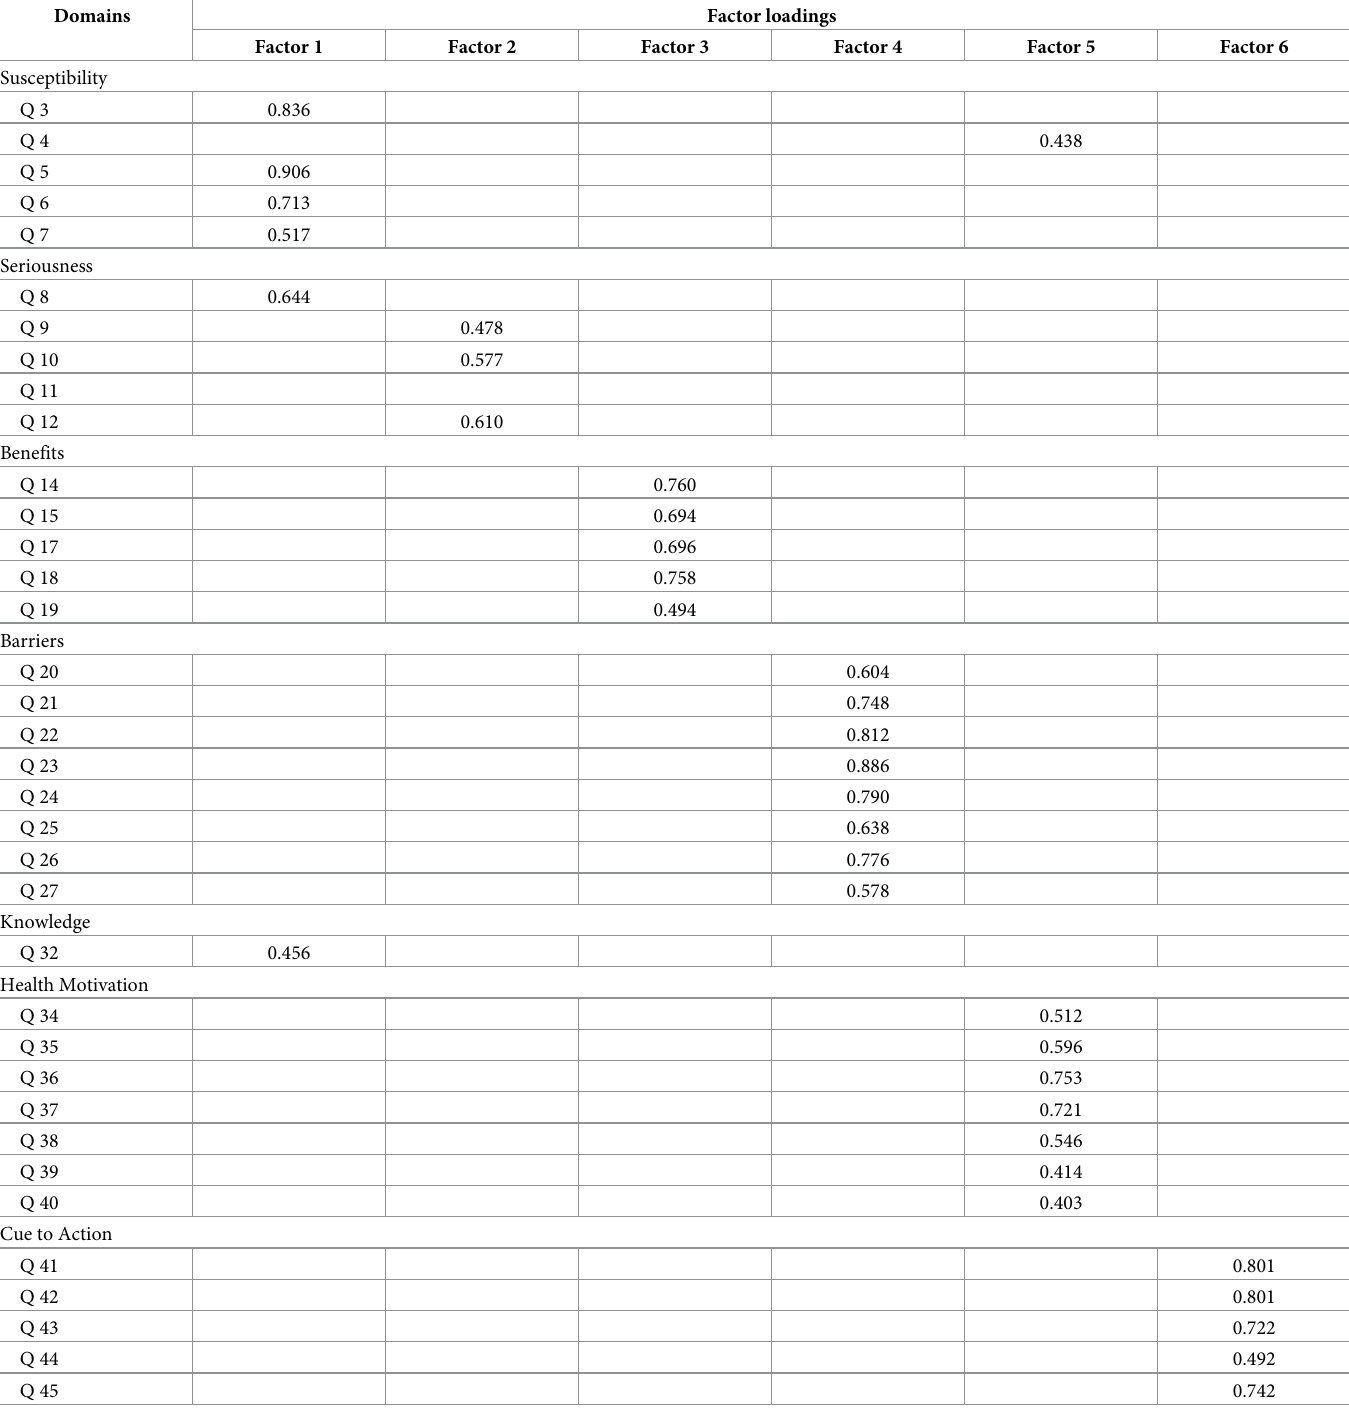
Table 2. Exploratory factor analysis of the Health Belief Model Applied to Influenza in among people with chronic diseases in Serbian language (Q—question).